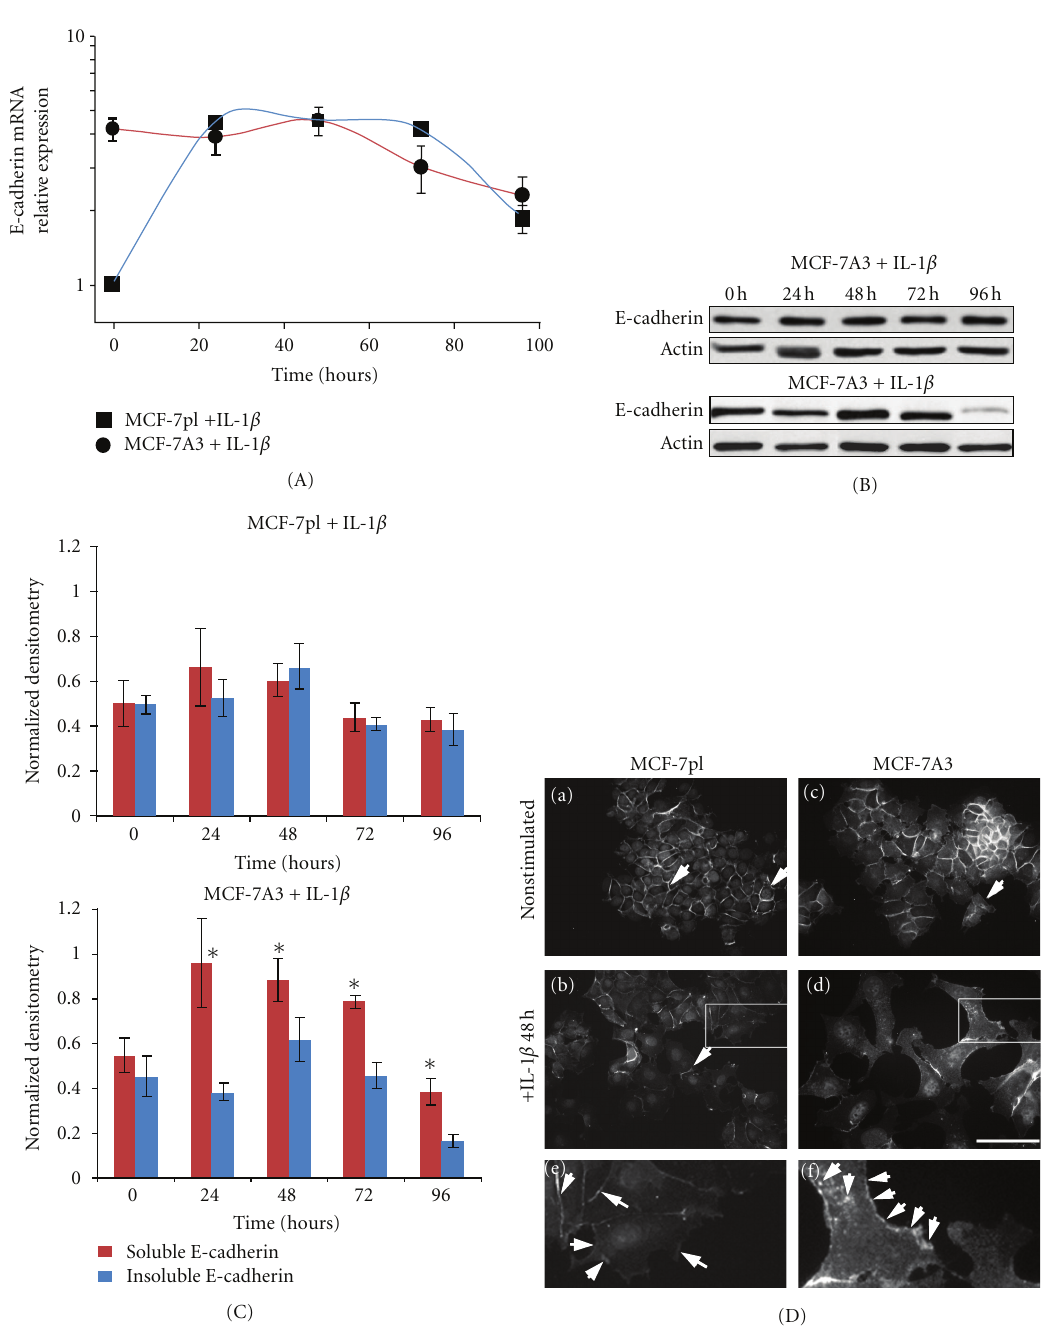
Figure 4: Characterization of E-cadherin mRNA expression and E-cadherin levels in MCF-7pl and MCF-7A3 cells. (A) Relative expression profile of E-cadherin mRNA. MCF7-7pl and MCF-7A3 cells were stimulated with IL-1 β as previously indicated. After stimulus, gene expression was evaluated by qRT-PCR at the indicated time points. Data are presented as mean ± SD and normalized to the basal expression of E-cadherin mRNA in nonstimulated MCF-7pl cells (Time zero). (B) Representative Western Blots showing the levels of E-cadherin in IL-1 β -stimulated MCF-7pl and MCF-7A3 cells at the times when E-cadherin mRNA expression was evaluated. Protein blots were challenged with anti-E-cadherin antibody. (C) Densitometric analysis of Western Blots against E-cadherin in Triton X-100 soluble and insoluble cell fractions in MCF-7pl and MCF-7A3 cells stimulated with IL-1 β obtained from three independent experiments. Data is presented as normalized densitometry relative to time zero, where sum of densitometry values from both Triton X-100 insoluble and soluble E-cadherin bands was set equal to 1. ∗ P < 0 . 05. (D) Immunolocalization of E-cadherin in MCF-7pl and MCF-7A3 cells. Nonstimulated or IL-1 β - stimulated cells were fixed and stained for immunofluorescence with anti-E-cadherin antibody and a secondary antibody tagged with FITC and nuclei counter-stained with DAPI. Bar = 20 μ m. Micrographs (e) and (f) are magnifications of the cells within the rectangles in micrographs (b) and (d), respectively. Arrows indicate localization of